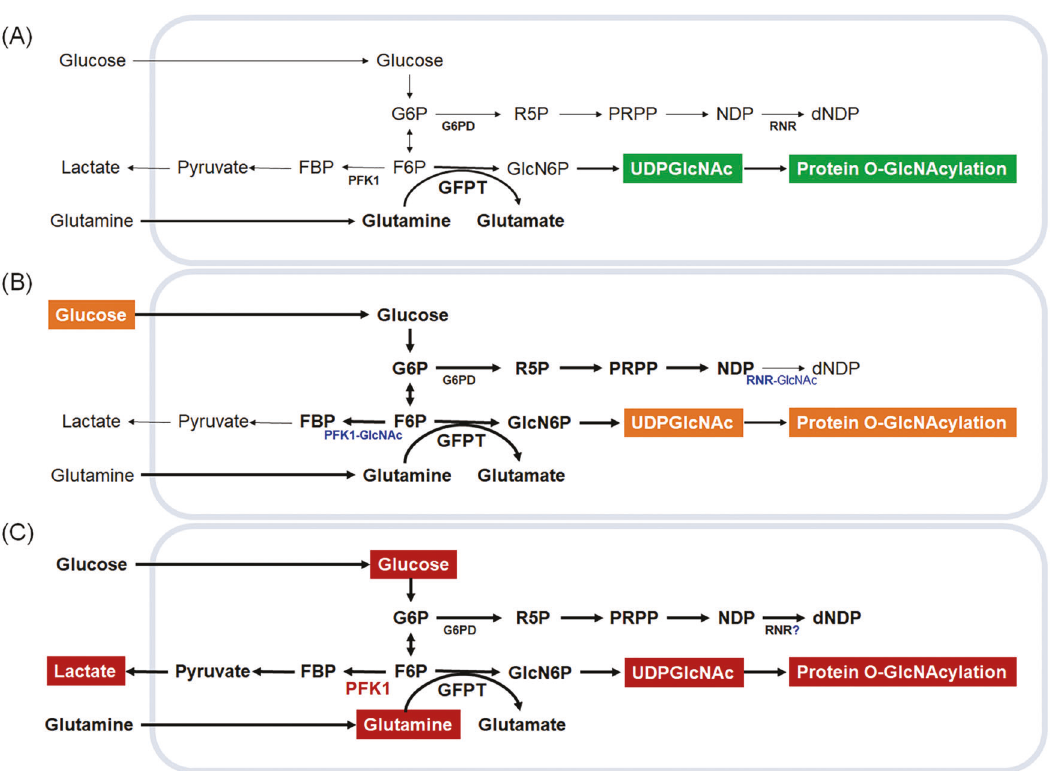
Fig. 3 Availability and utilization of glucose and glutamine to generate uridine diphosphate-N-acetylglucosamine (UDP-GlcNAc) in different states in pancreatic cells. A During resting, approximately 2 – 5% of cellular glucose enters the hexosamine biosynthesis pathway (HBP) to generate the end product UDP-GlcNAc. B During adaptation, high glucose induces genome instability through O-linked-N- acetylglucosaminylation (O-GlcNAcylation) of phosphofructokinase 1 (PFK1) and ribonucleotide reductase catalytic subunit M1 (RRM1) to direct glycolysis and the pentose phosphate pathway (PPP) into the HBP. C During hyperproliferation, such as in pancreatic cancer cells, both high glucose and high glutamine are required through overactivation/overexpression of PFK1, shunting glycolysis into the PPP and HBP to generate energy and biosynthesis precursors to meet the needs of cancer cells. G6P glucose 6-phosphate, F6P fructose 6-phosphate, FBP fructose 1,6-phosphate, GFAT glutamine:fructose-6-phosphate amidotransferase, R5P ribose 5-phosphate, PRPP phosphoribosyl